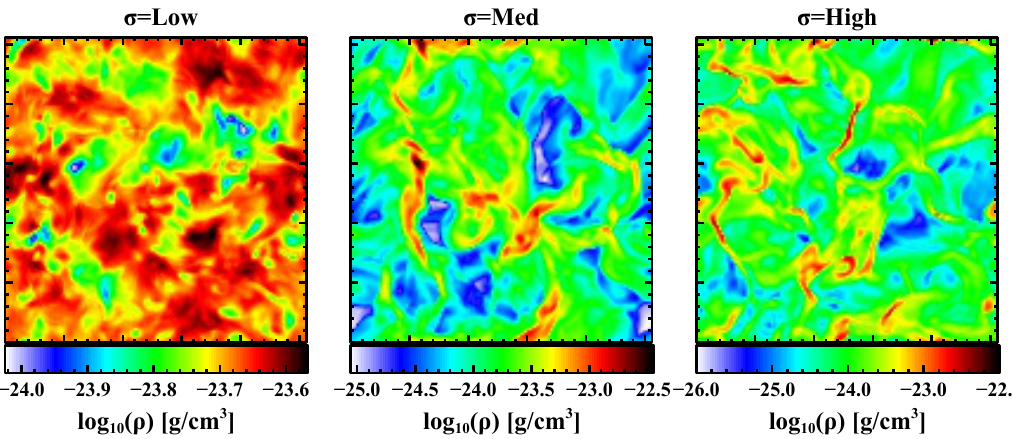
Figure 5. An illustration of how the gas density structure changes with increasing levels of turbulence, σ , made with MAIHEM and presented in the talk by William Gray. At low σ the turbulence is subsonic and no shocks are formed creating a nearly uniform density distribution. At intermediate and high σ , shocks form and create regions of very high and low